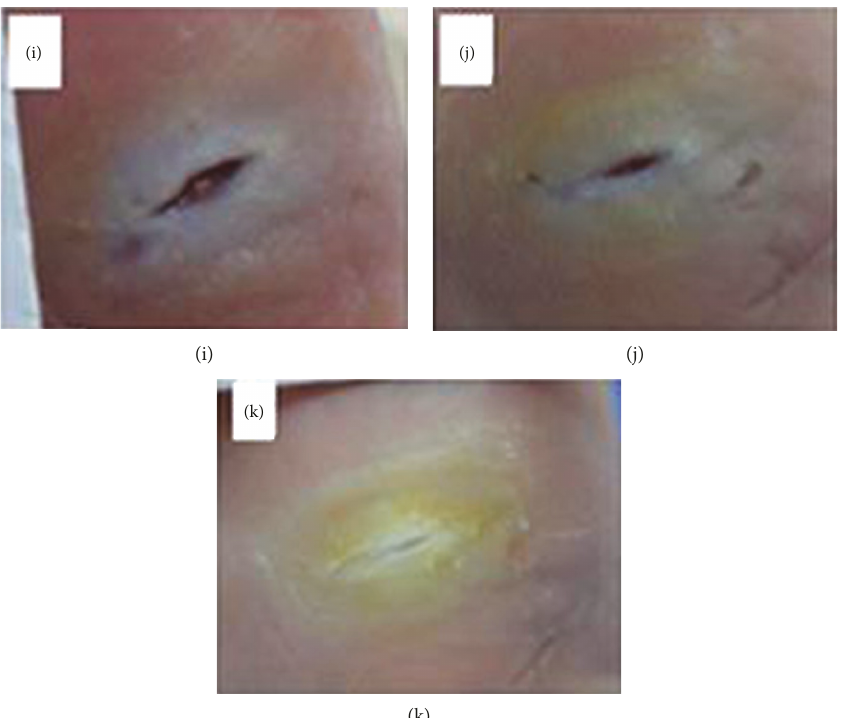
Figure 5: Photo clinical follow-up. Patient 1: control group: (a) ulcerated foot region; (b) pretreatment (initial); (c) posttreatment (1 week); (d) 2 weeks; (e) 3 weeks; (f) 4 weeks; (g) 5 weeks; (h) 6 weeks; (i) 7 weeks; (j) 8 weeks; (k) 9 weeks. This fi gure is reproduced from Reis [42], public